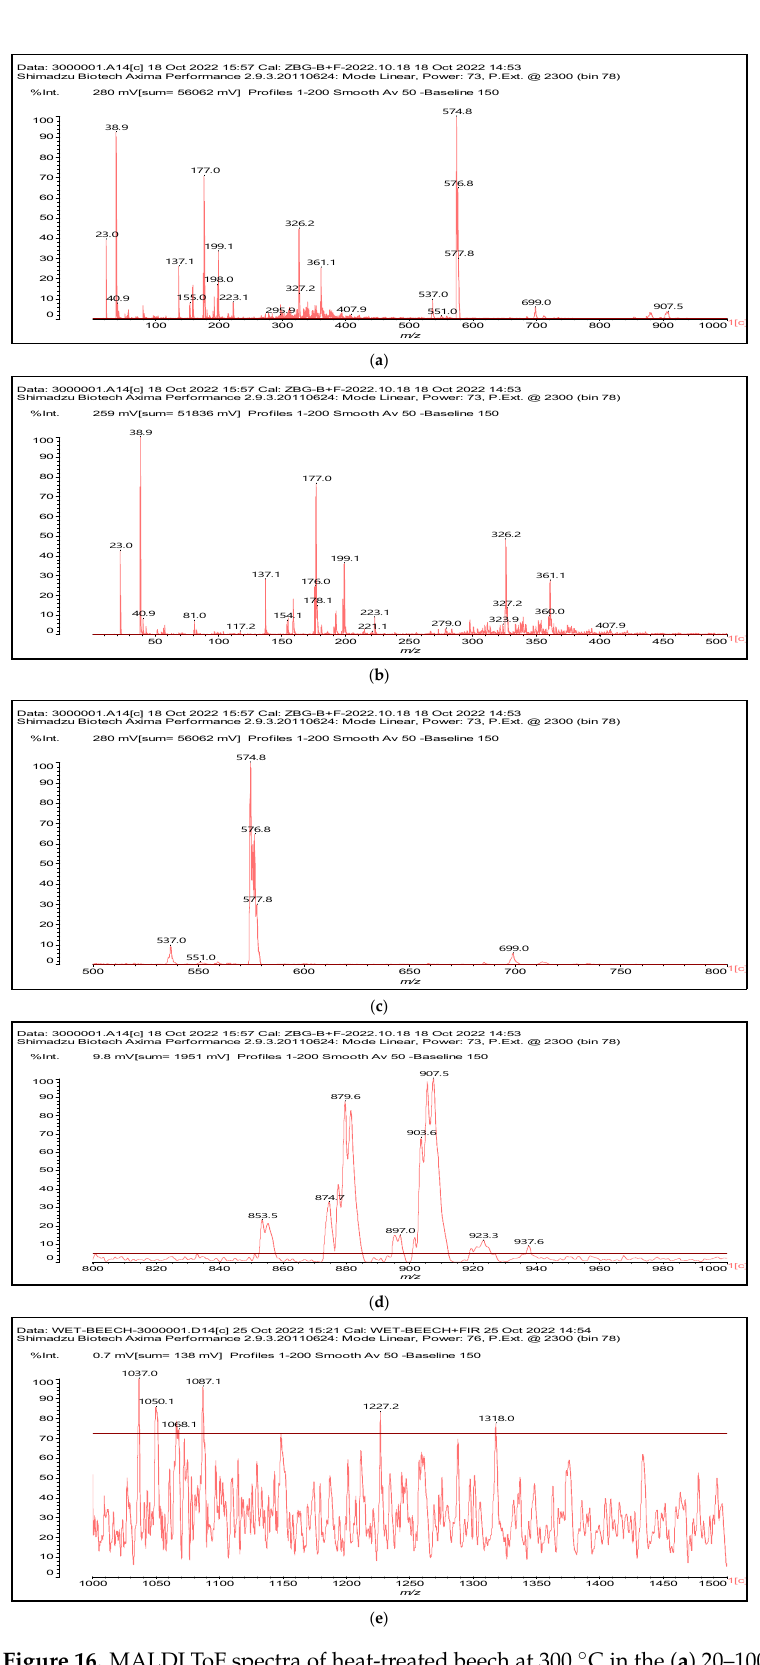
Figure 16. MALDI ToF spectra of heat-treated beech at 300 °C in the ( a ) 20–1000 Da range and details of the ( b ) 20–500 Da range, ( c ) 500–800 Da range, ( d ) 800–1000 Da range, ( e ) 1000–1500 Da range. Table 1. Assignment of species to the MALDI ToF peaks for beech wood heat-treated at 300 °C after heat treatment and underlined in green after a high moisture treatment at 95% relative humidity for one week.